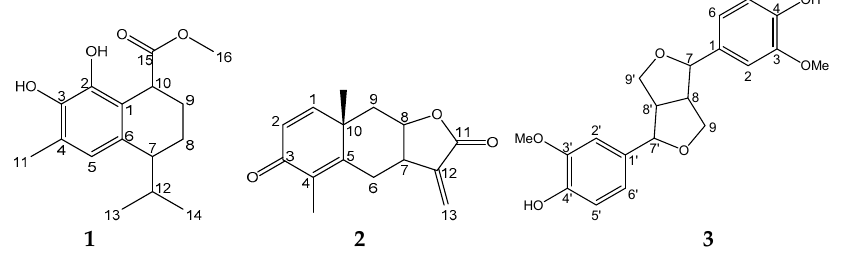
Figure 2. Structures of 1 – 3 isolated from D. fragrans.